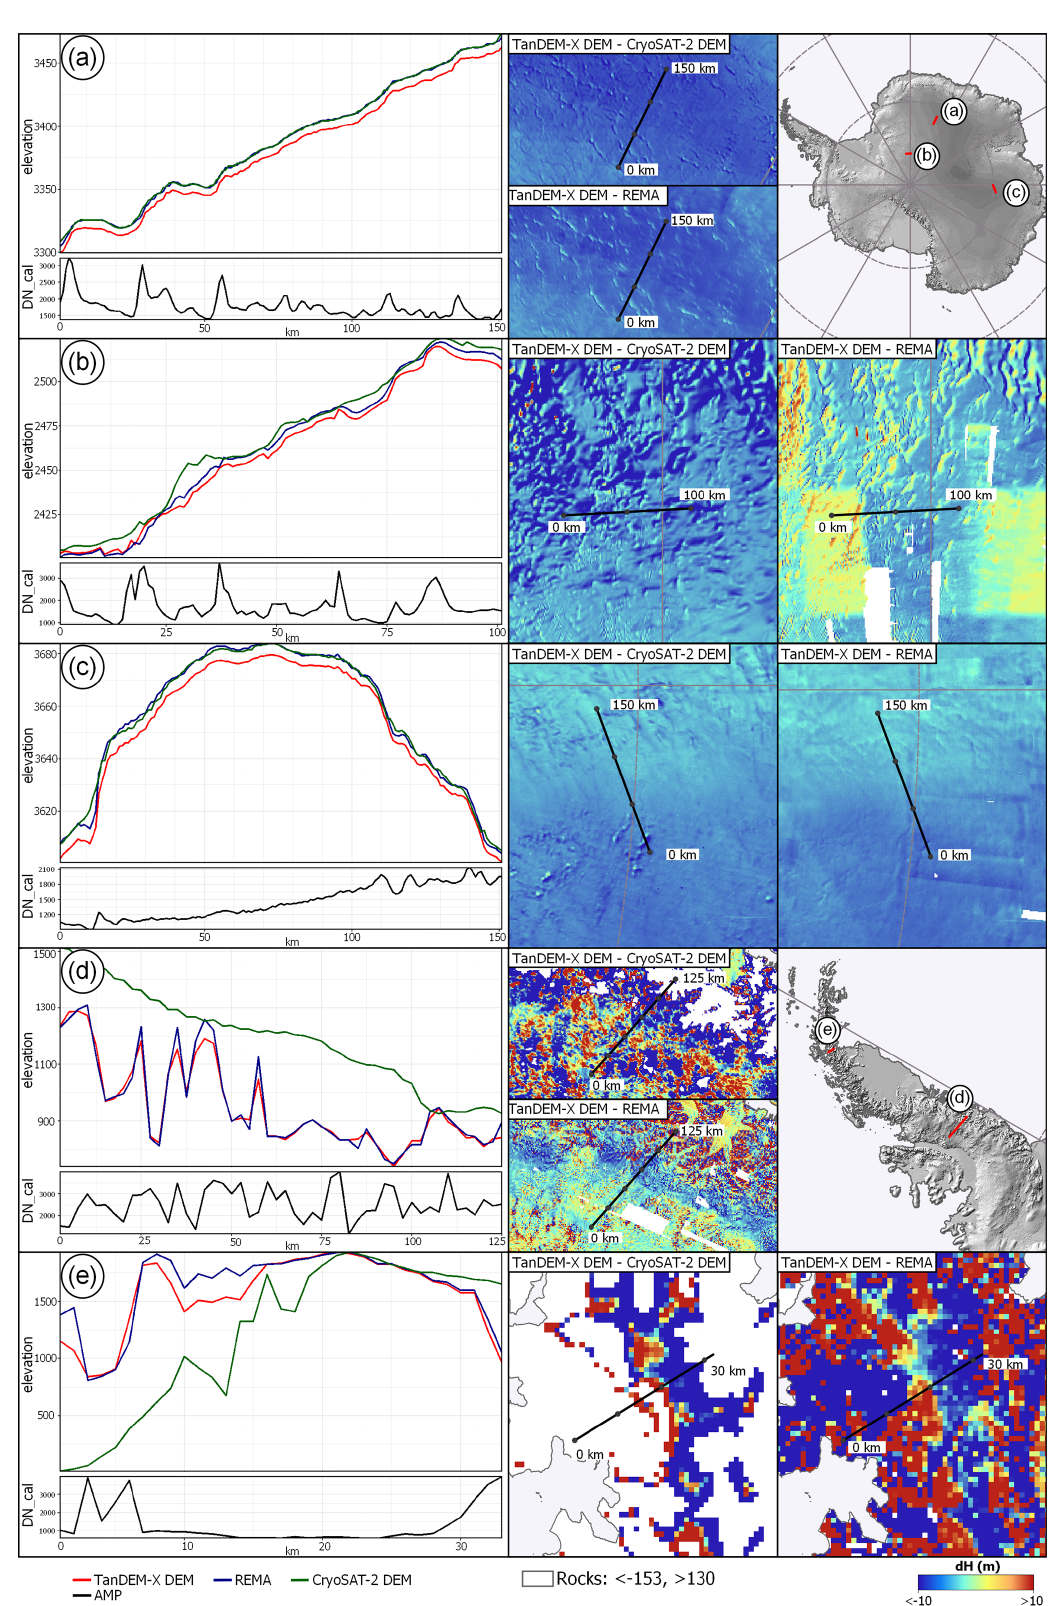
Figure 19. Left panels: profiles of TanDEM-X minus REMA, as well as minus CryoSat-2. Right panels: profile line plotted over the DEM